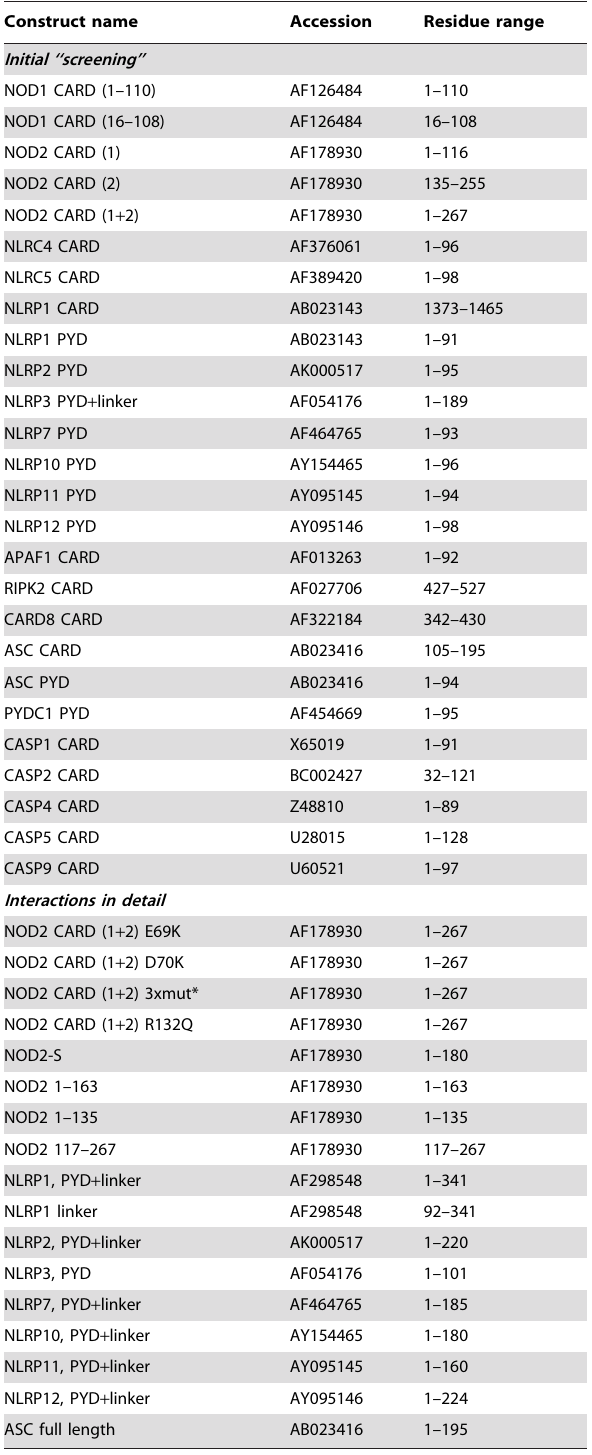
Table 2. Cloning of